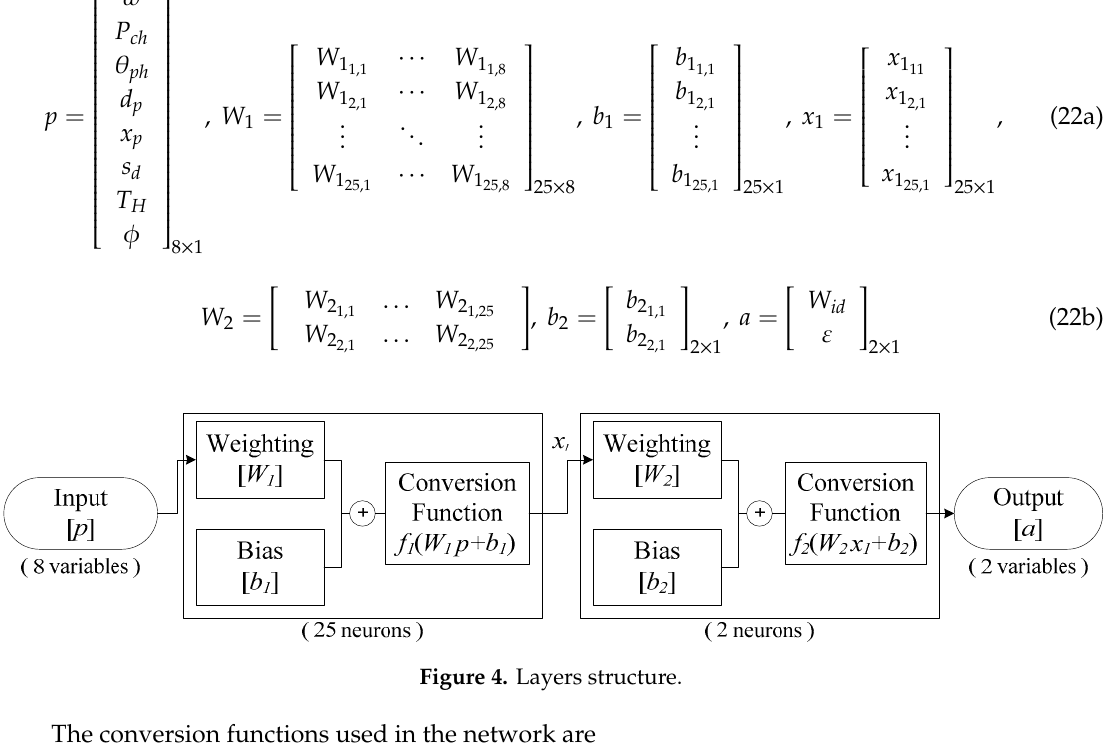
Figure 4. Layers structure.